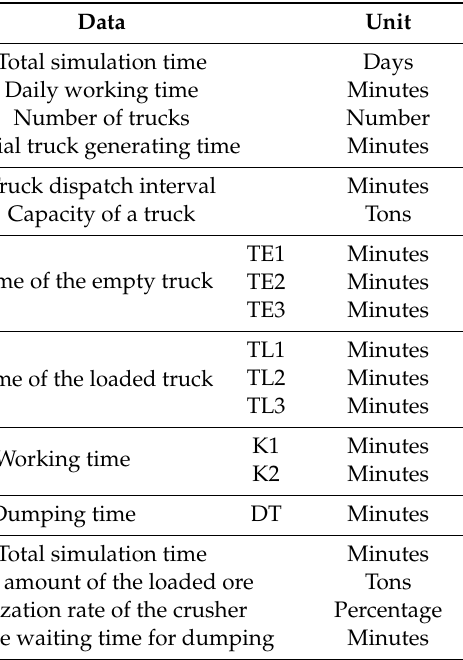
Table 3. Description of the input and output data of the truck haulage system